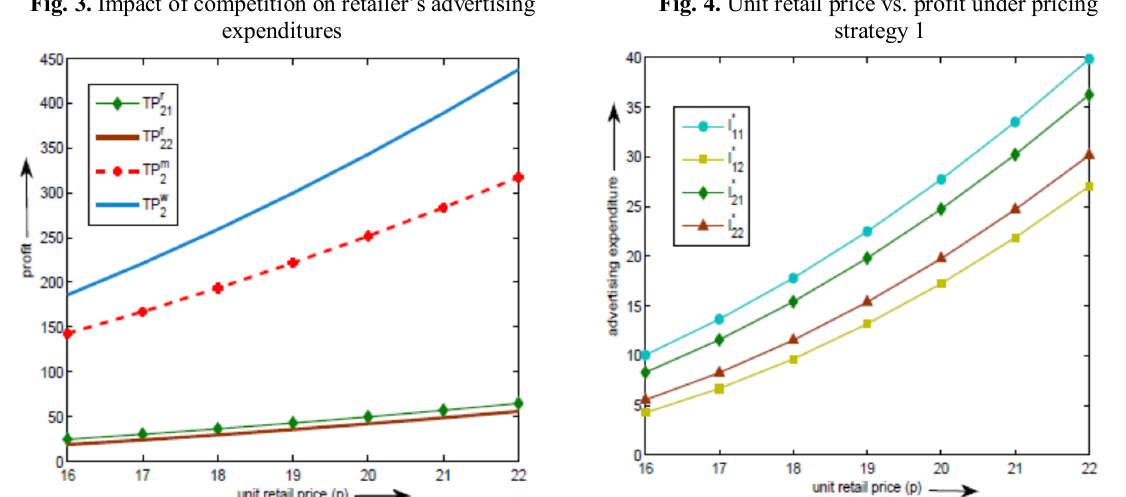
Fig. 3. Impact of competition on retailer’s advertising Fig. 4. Unit retail price vs. profit under pricing